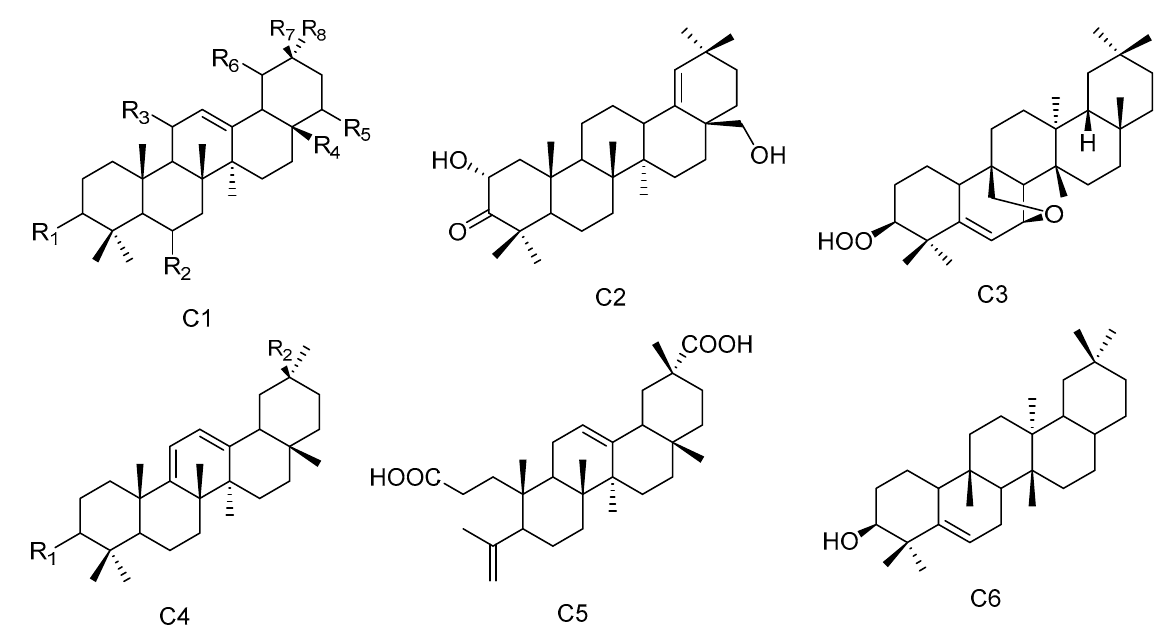
Figure 3. Six types (C1–C6) of oleanane triterpenes skeletons.